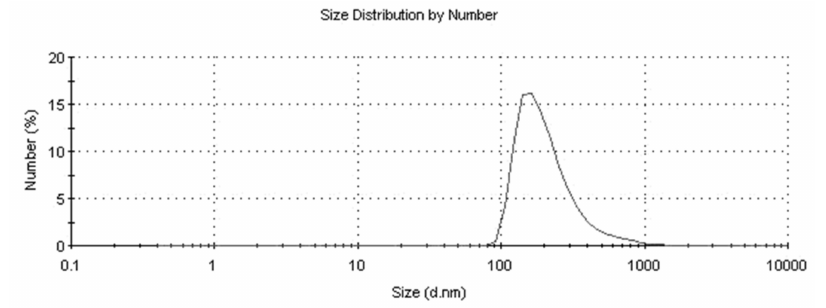
Figure 2. DLS diagram of the TEOS / O 8 TES based system.